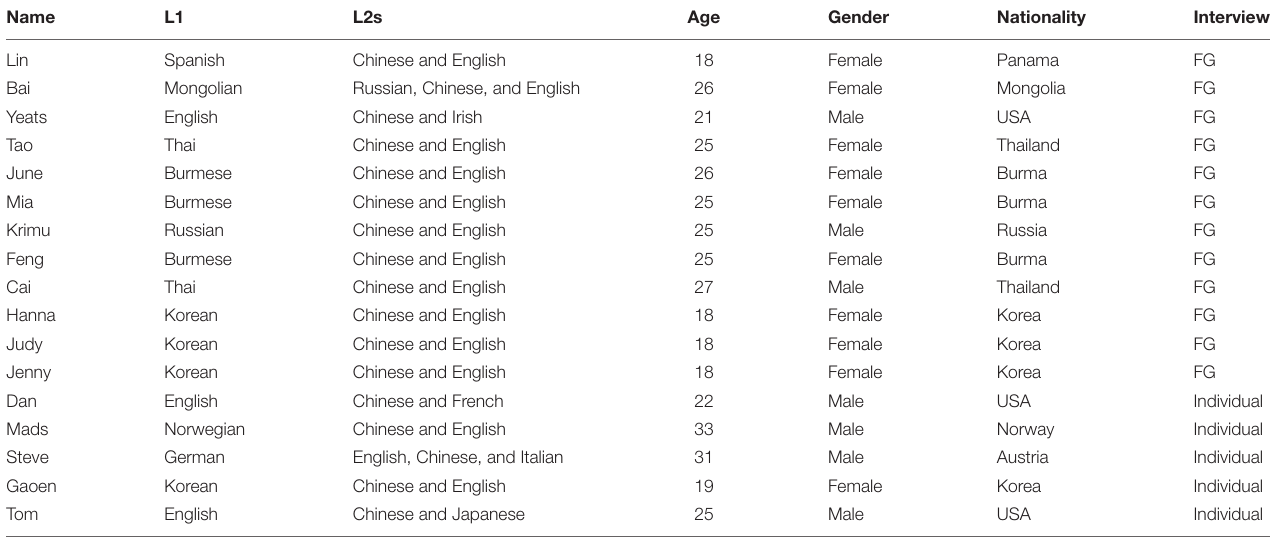
TABLE 1 | Background information of L2 Chinese